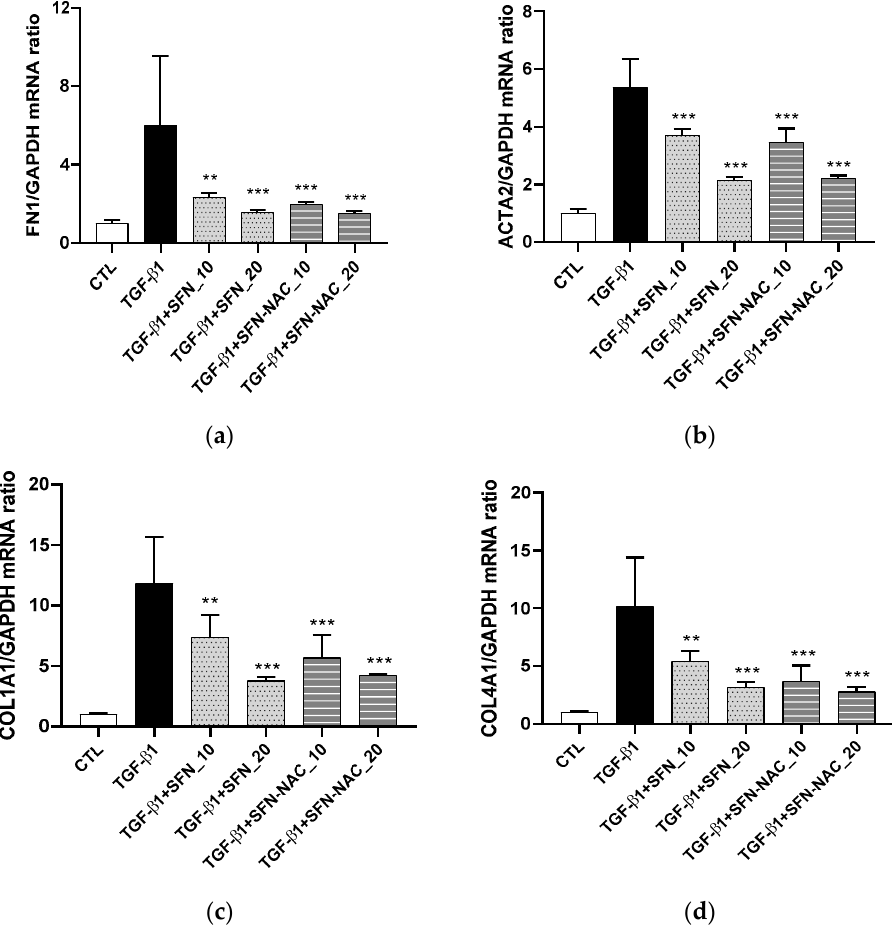
Figure 3. Effect of SFN and SFN-NAC treatment on the mRNA expression of ECM proteins and myofibroblast marker following TGF- β 1-induced fibrosis in MRC-5 fibroblast cells. The cells were pre-treated for 1 h with the indicated concentrations of SFN and SFN-NAC, followed by treatment with TGF- β 1 (5 ng/mL) for 48 h. mRNA levels of FN1 ( a ), ACTA2 ( b ), COL1A1 ( c ), and COL4A1 ( d ) were measured by qRT-PCR. Data values are expressed as the mean ± standard deviation of at least three different experiments. ** p < 0.01, *** p < 0.001 versus TGF- β 1 induction. ECM, extracellular proteins; TGF- β 1, transforming growth factor- β 1; SFN, sulforaphane; SFN-NAC, sulforaphane N -acetylcysteine; CTL, control; FN1 , fibronectin 1; ACTA2 , actin alpha2, smooth muscle; COL1A1 , type I collagen; COL4A1 , type IV